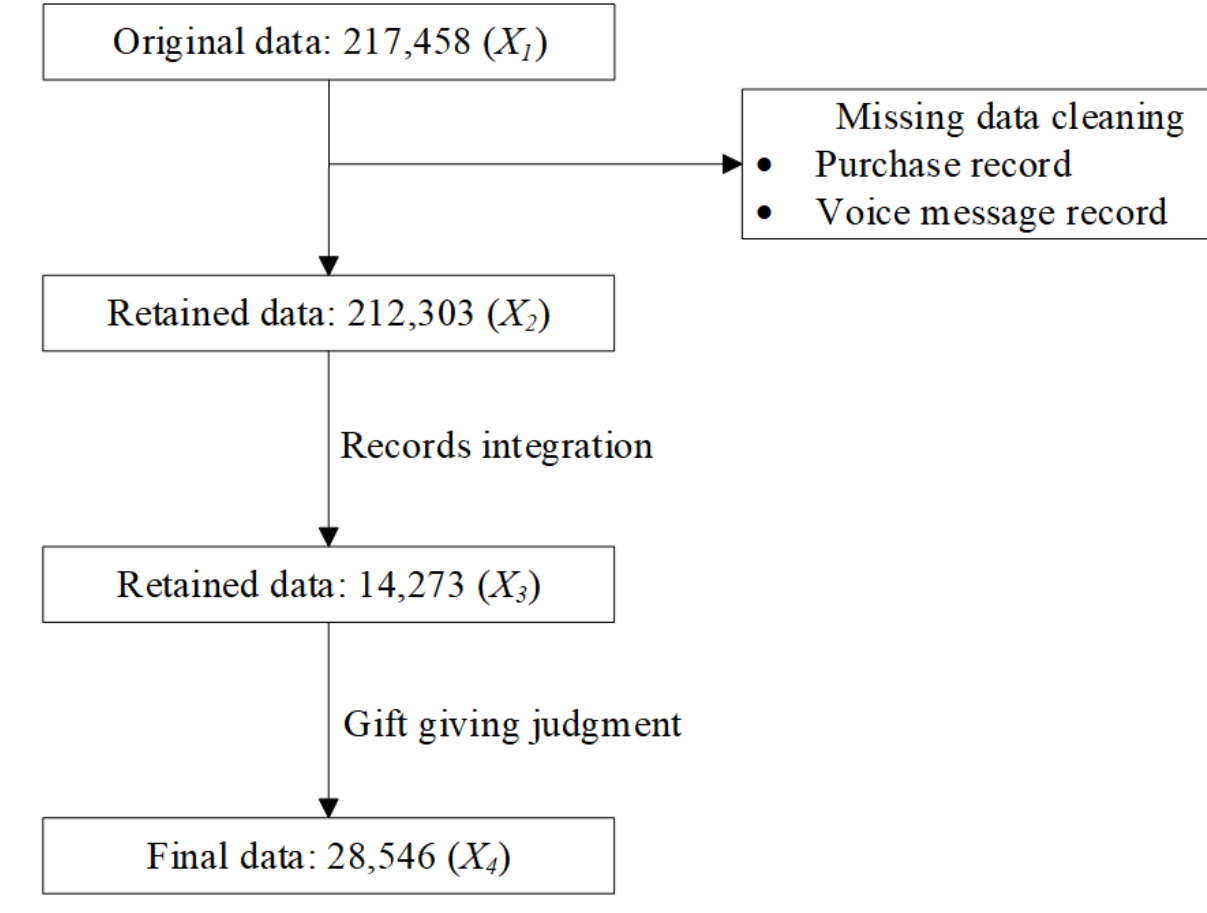
Figure 4. Data cleaning and processing.